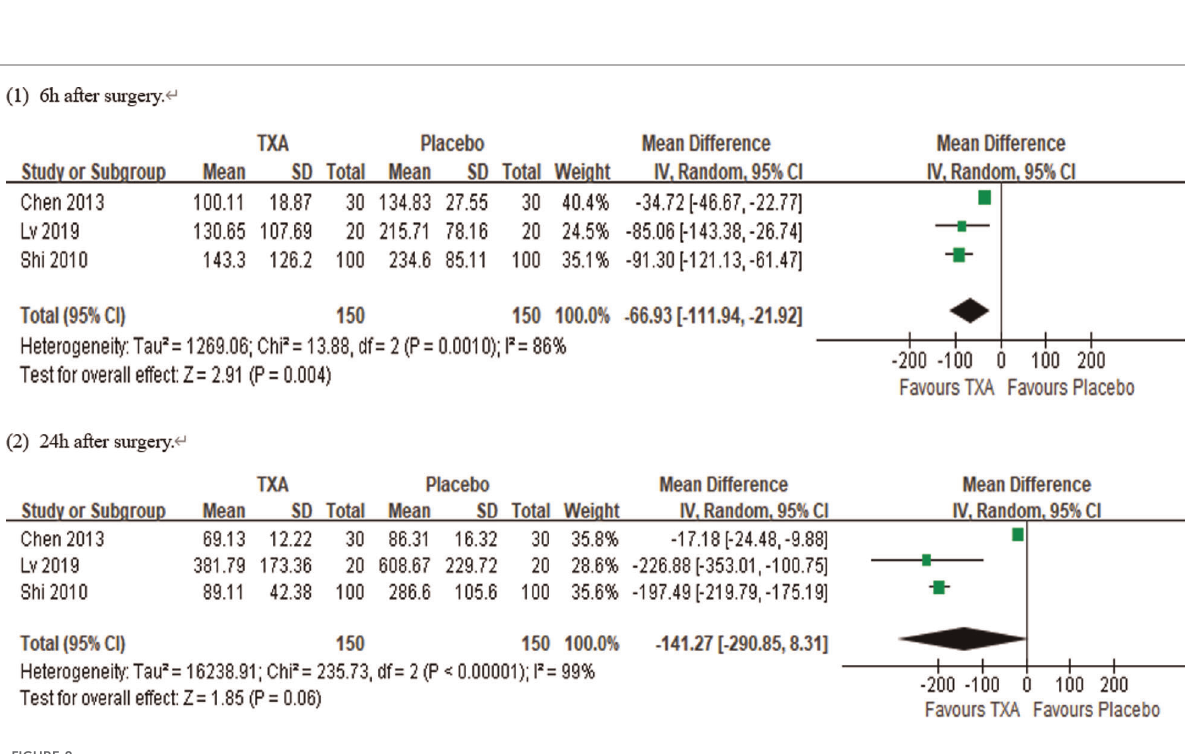
FIGURE 8 Forest plot comparing TXA and placebo for the neutrophil elastase (NE)